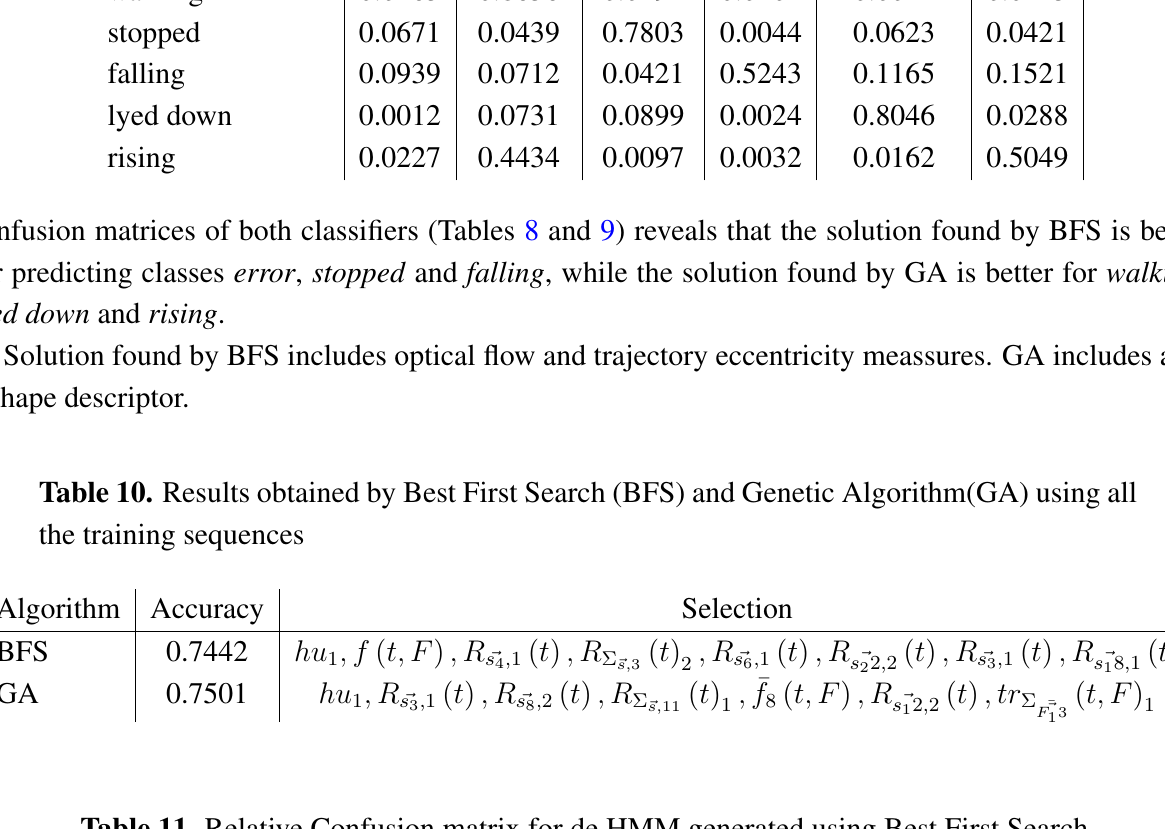
Table 11. Relative Confusion matrix for de HMM generated using Best First Search (cid:80) (cid:80) (cid:80) (cid:80) (cid:80) (cid:80) (cid:80) (cid:80) (cid:80) (cid:80)(cid:80) class